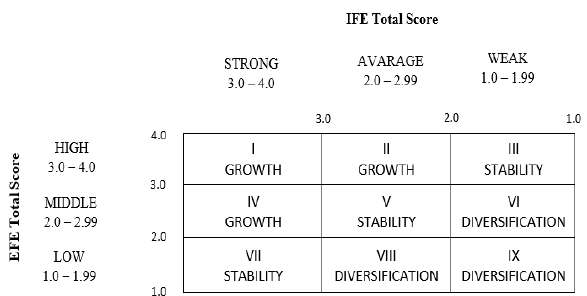
Figure 4 . Internal-External (IE) matrix